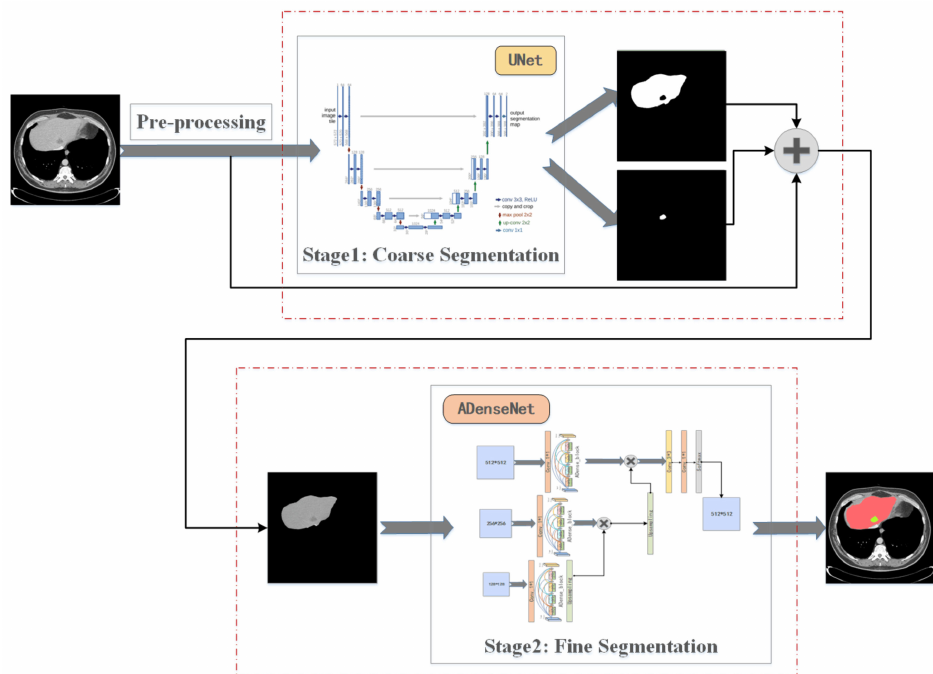
Figure 1. Main steps of this work for the segmentation of the liver and